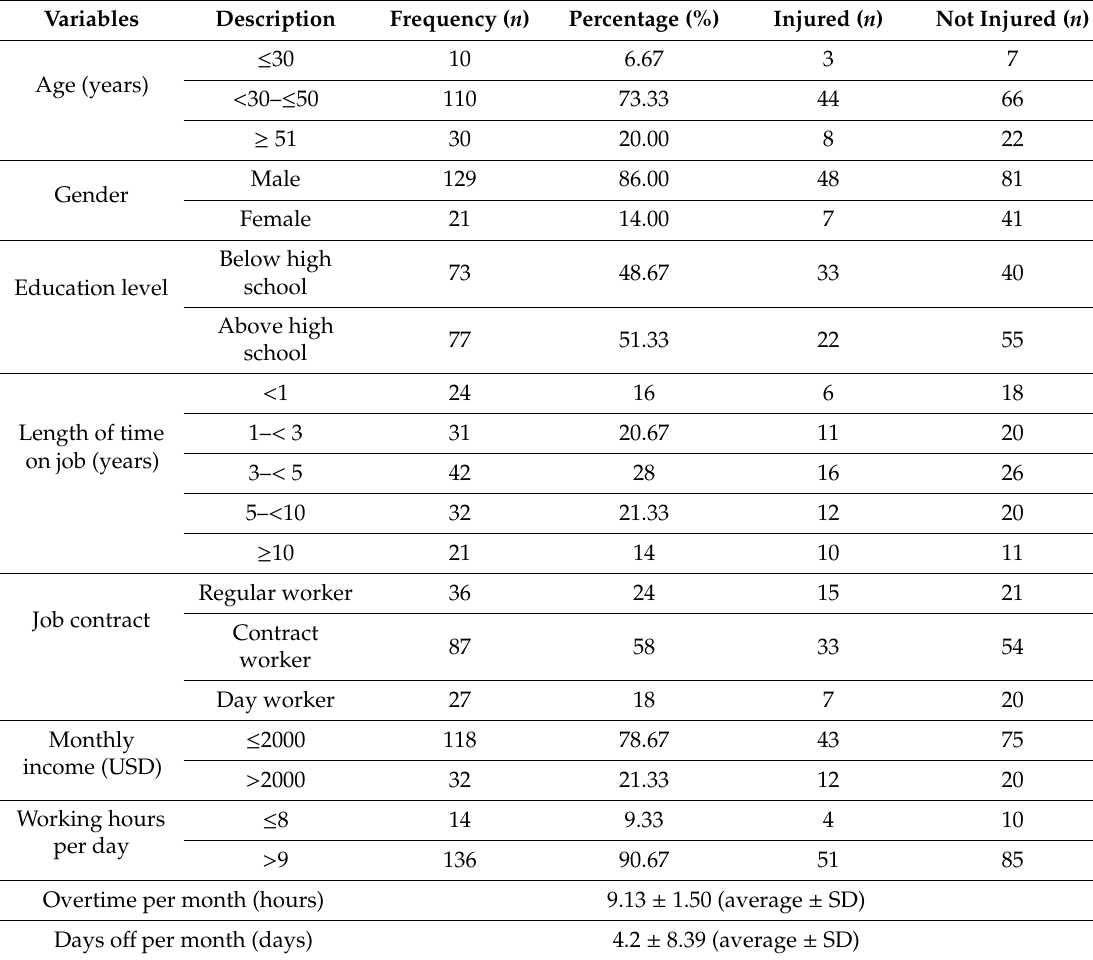
Table 2. Street cleaner characteristics and injuries (N =